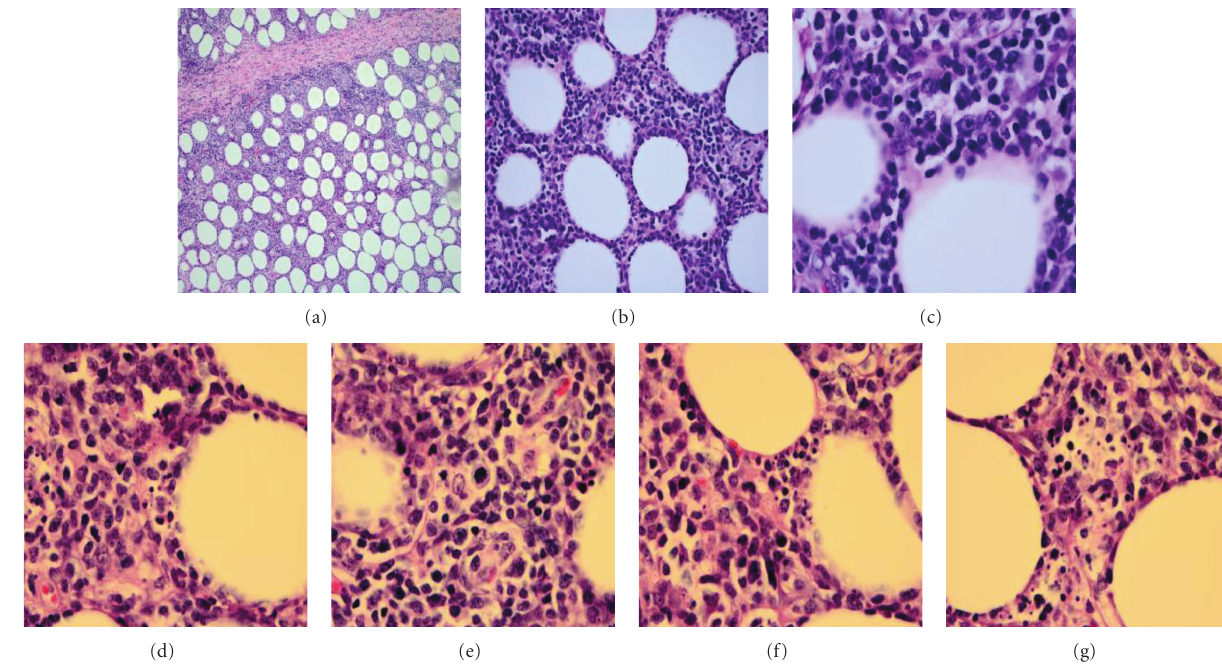
Figure 2: Biopsy of soft tissue from the left thigh revealed: (a) at 10x magnification shows lymphoid infiltrate with pattern resembling lobular and septal panniculitis, and (b) at 40x magnification shows lymphoid infiltrate with abundant cytoplasm. At 100x magnification with oil-immersion biopsy showed (c) atypical lymphoid cells with atypical and irregular nuclei as well as numerous fat cells, (d) numerous single-cell necroses and atypical lymphoid infiltrate, (e) mitotic figure in the center with areas of necrosis and fibrosis, (f) mitotic figure with scattered histiocytes and area of necrosis, and (g) area of necrotic